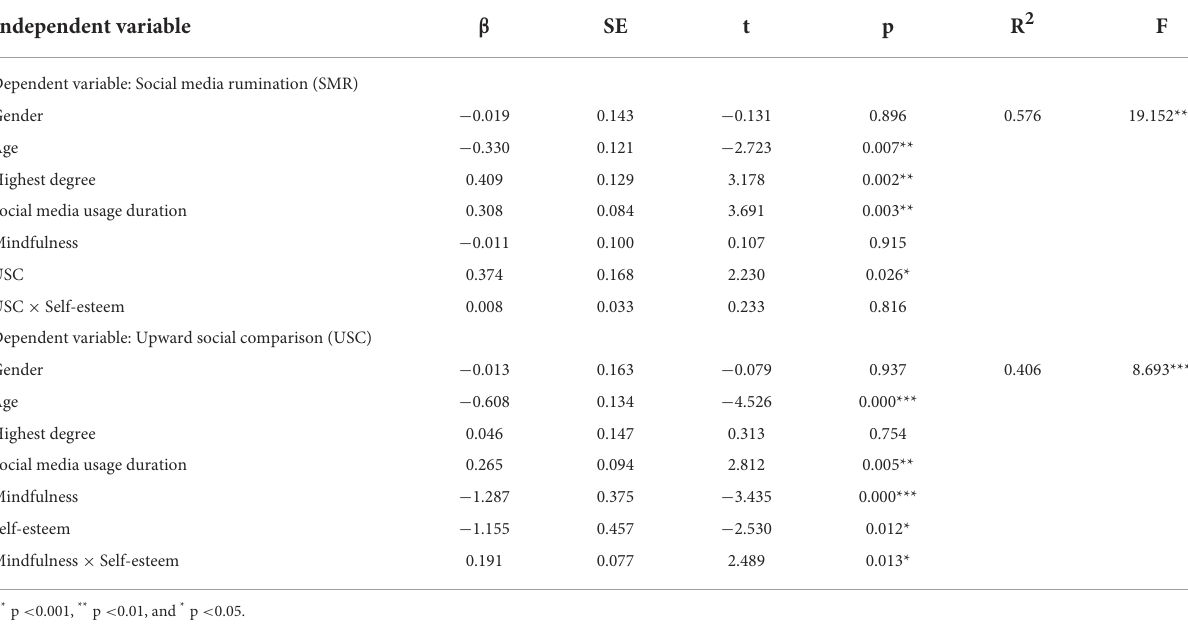
TABLE 4 Moderated mediation model’s multiple regression results.